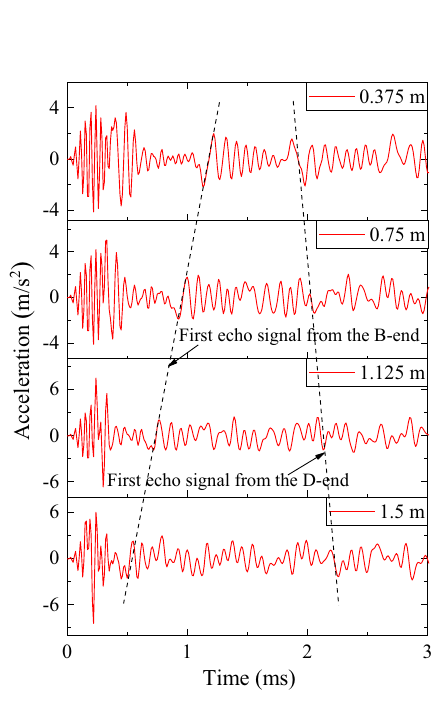
Fig. 13 Wave propagation signals with different bond lengths under 25 kN pull-out